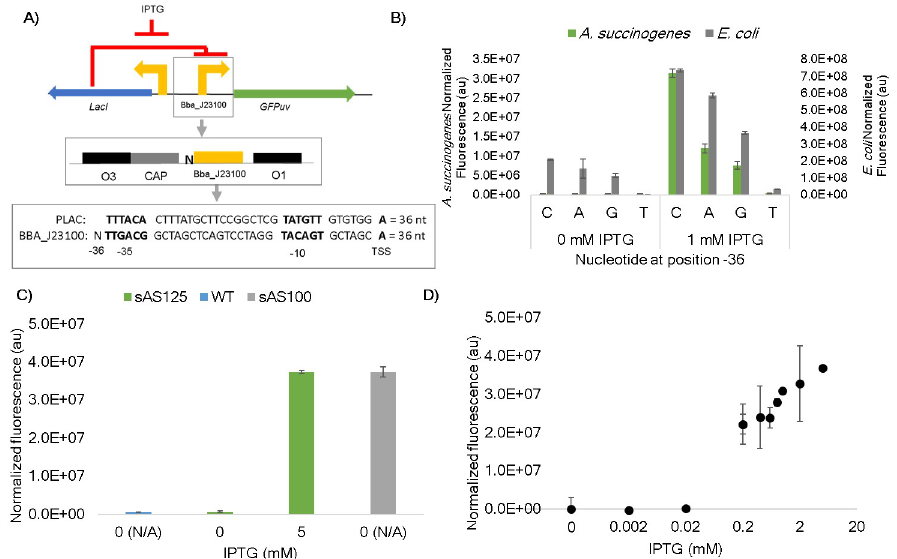
Fig 4. Characterization of strain sAS125 containing SSBIO-AS004 using GFPuv as the reporter protein. (A) Schematic of the expression system used in SSBIO-AS004 showing strategy of where to include the extra nucleotide to make size and spacing equivalent. (B) Comparison of expression variation due to the -36 nucleotide in both A . succinogenes and E . coli normalized by absorbance and respective wild type (Materials and Methods) at 0 and 1 mM IPTG. (C) Comparison of on and off states of sAS125 at 0 and 5 mM IPTG with wild type A . succinogenes and strain sAS100. Fluorescence values are normalized by absorbance (Materials and Methods). (D) Induction of sAS125 at IPTG levels ranging from 0.002 to 5 mM. Fluorescence values are normalized by absorbance and wild-type. All error bars represent one standard